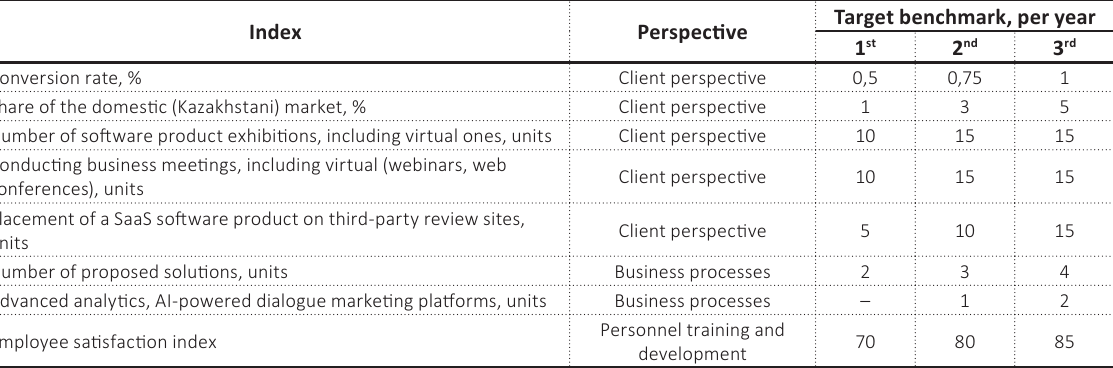
Table 6. Key objectives and performance indicators